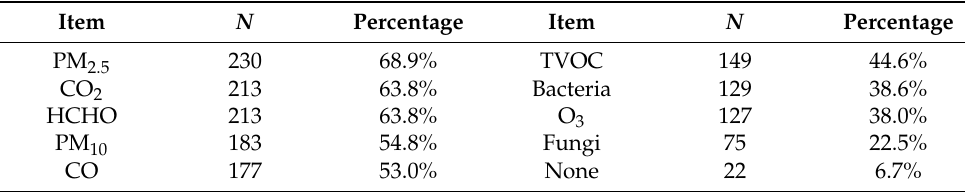
Table 6. The cognition of indoor air